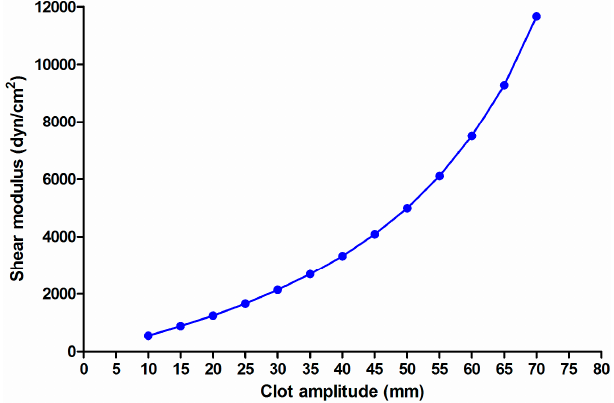
Figure 3. Non-linear relationship between clot amplitude and shear modulus.